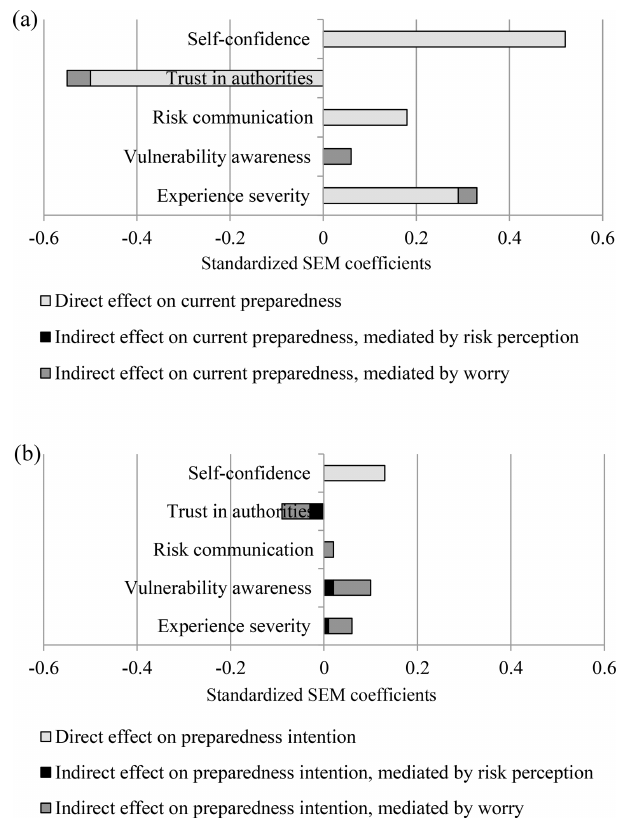
Figure 4. Total effects (SEM standardized coefficients) of the FPB model’s predictor variables on the current preparedness (a) and the preparedness intention (b) . Each total effect is further analyzed as direct effects and indirect effects mediated by risk perception and